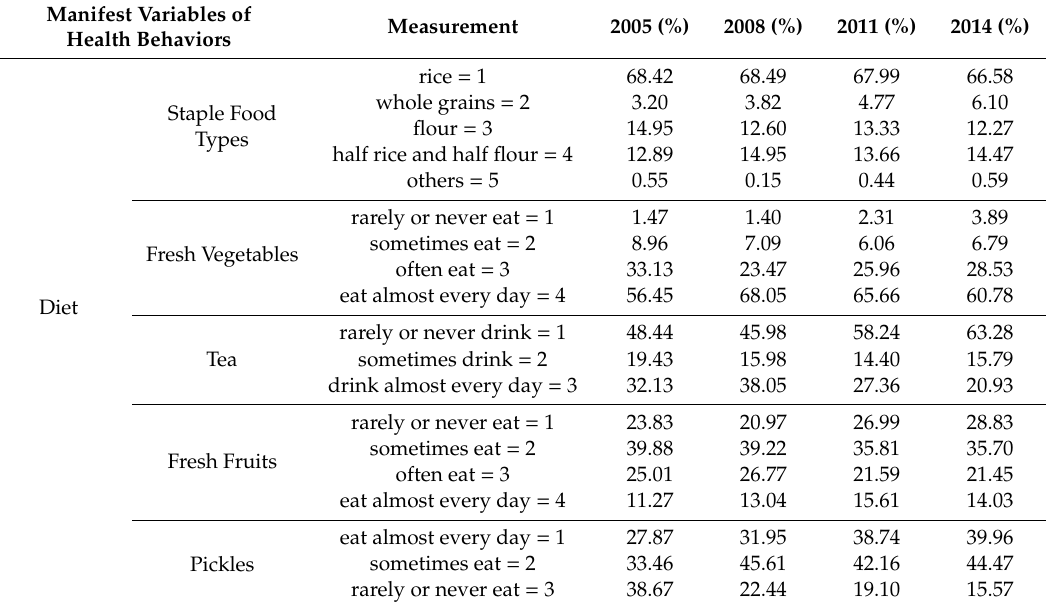
Table 1. Descriptive statistics for manifest variables of health